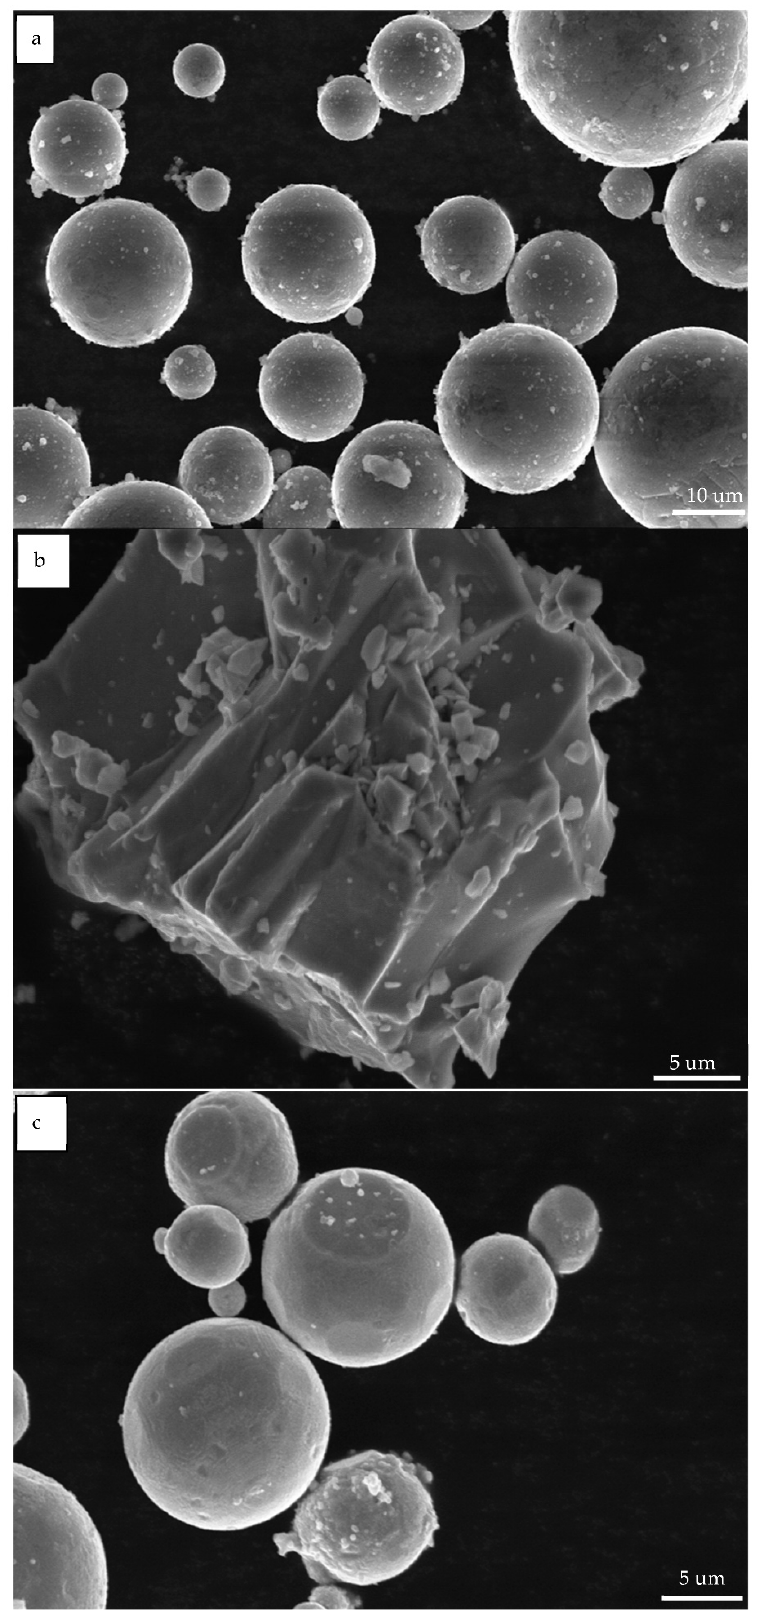
Figure 3. Original powder morphology of Mg-Mn-Zn material: ( a ) Mg powder, ( b ) Mn powder, and ( c ) Zn